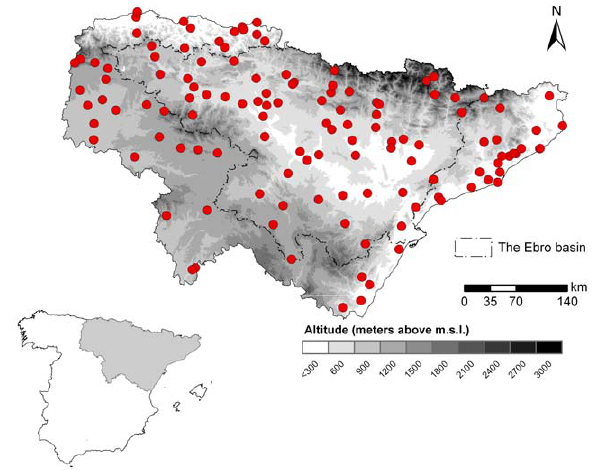
Figure 1. Location of the study area and spatial distribution of the meteorological Fig. 1. Location of the study area and spatial distribution of the stations. meteorological